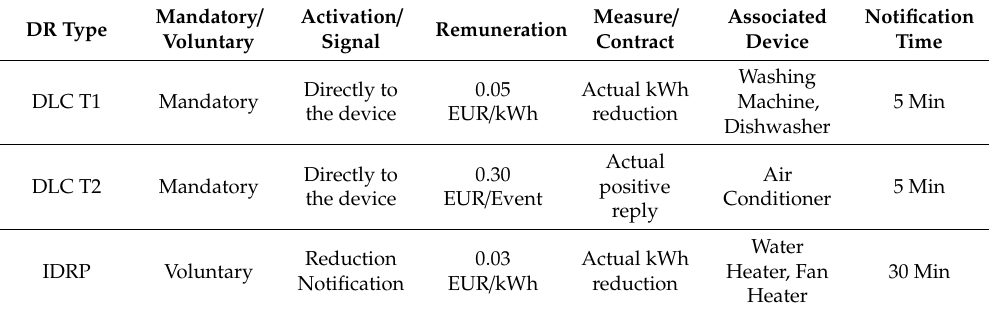
Table 1. DR contracts available for consumers to establish with